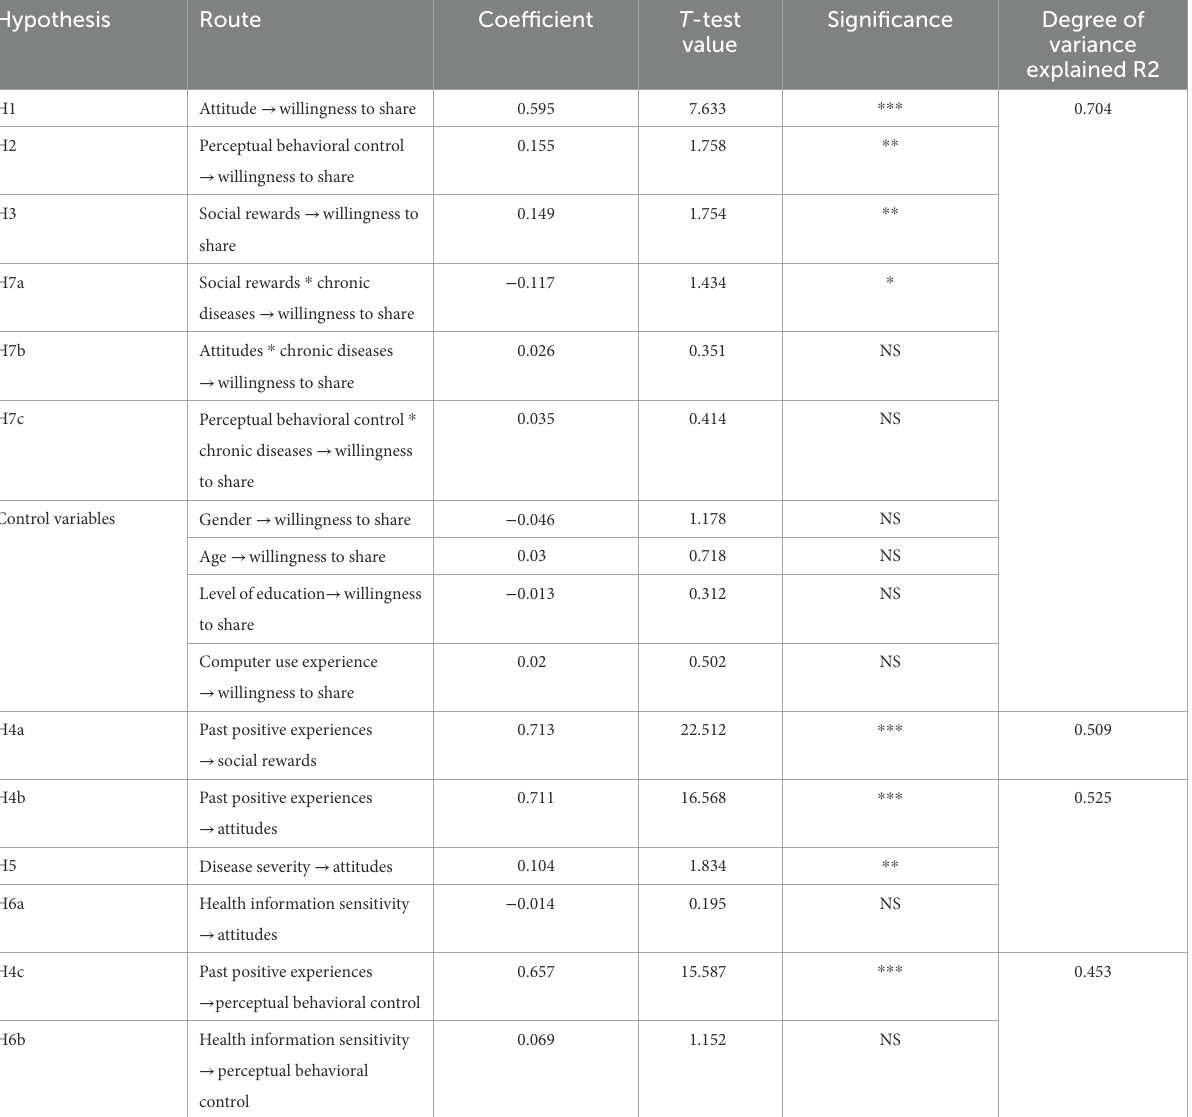
TABLE 4 Complete model validation results. a